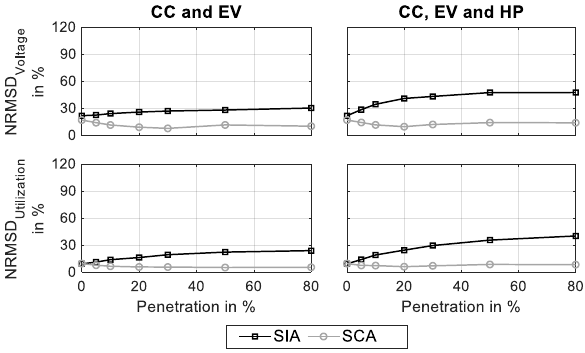
Figure A6. Load approach-induced normalized root mean square deviations (NRMSDs) compared to the TSA in terms of voltage characteristics and thermal utilization considering the urban LV grid located in the city outskirts.